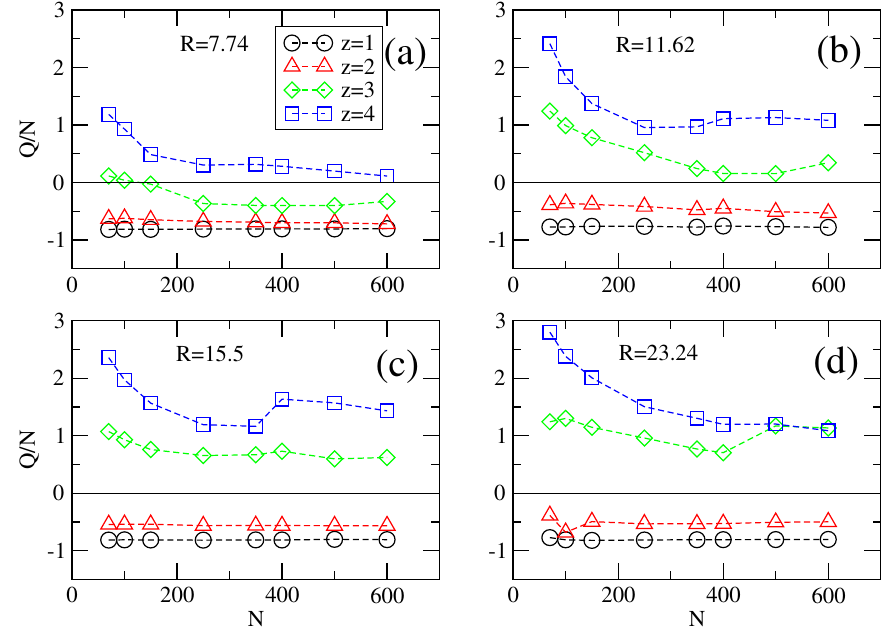
Figure 9. Effective charge Q per chain length N for non-zero longitudinal field E and zero transversal field E = 0 , as a function of N for ( a – d ) different radii ⊥ R = 7 . 74 , 11 . 62 , 15 . 5 and 23 . 24 of the cylinder,